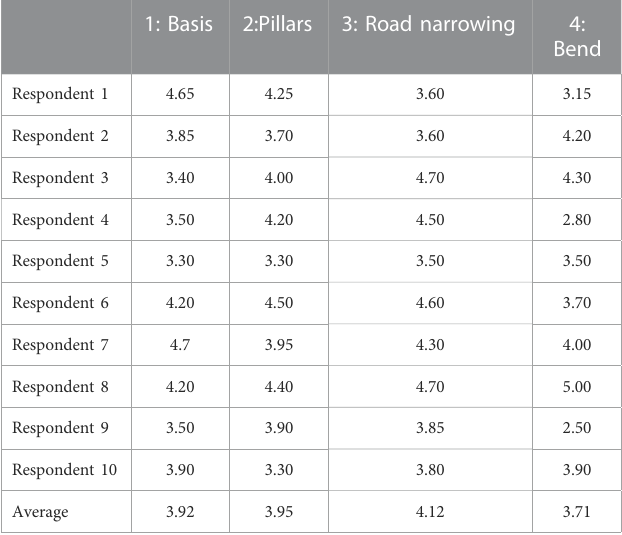
TABLE 10 Acceptance scores per respondent per scenario.